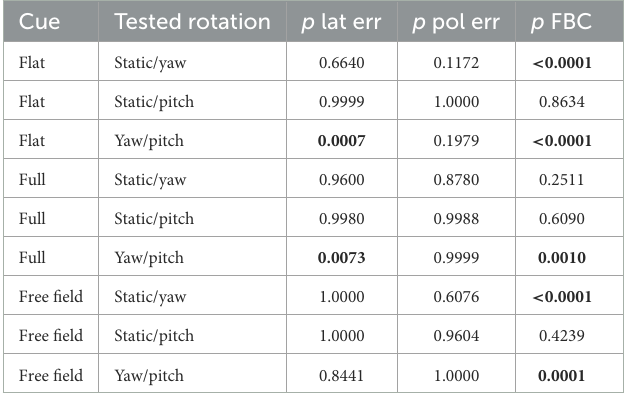
TABLE 1 Statistical significance of differences in three localization performance metrics (lateral error, polar error, FBC rate) between the tested types of head rotation, grouped by the type of acoustic cues.